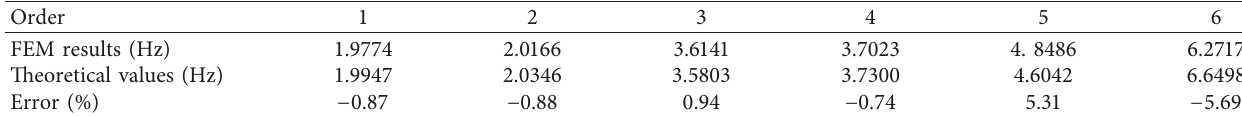
Figure 6: Modal picture of vibrating screen (1 ∼ 6 orders). (a) 1st order. (b) 2nd order. (c) 3rd order (d) 4th order. (e) 5th order (f) 6th order. Table 3: Comparison of FEM results with theoretical